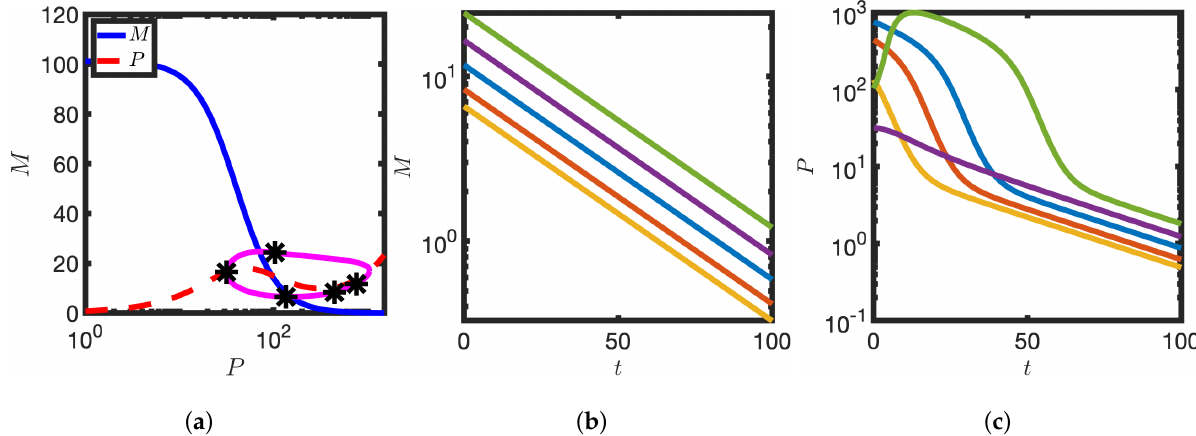
Figure 7. Protein decay is multimodal upon complete transcriptional inhibition. ( a ) A set of representative points (markers) is chosen on the limit cycle cycle solution. Other details as in Figure 5b. ( b ) mRNA levels are plotted against time. ( c ) Protein levels are plotted against time. Initial conditions given by each of the markers in ( a ). Equation (2) were solved numerically. See Table 1 for parameter